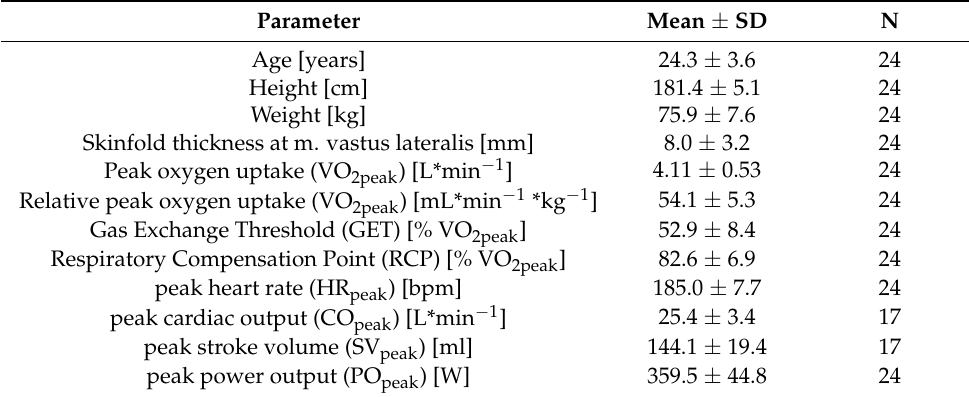
Table 1. Subject